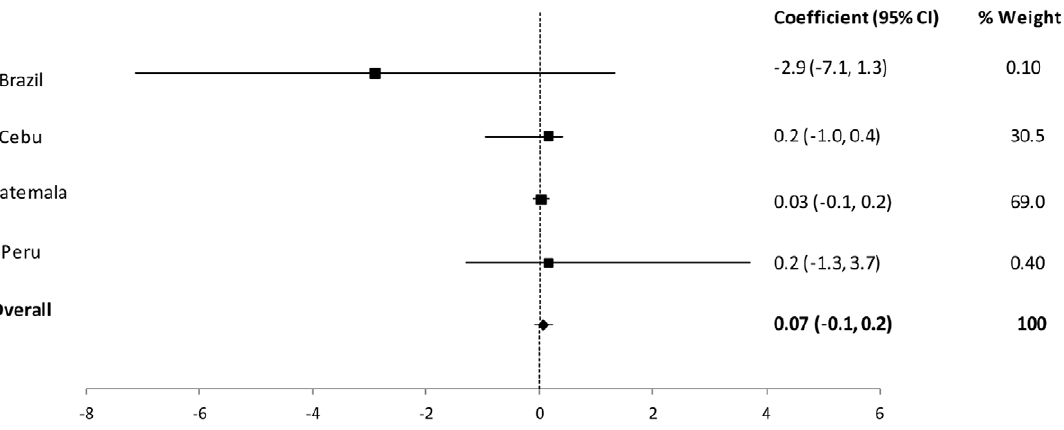
Figure 1. Forest plot of the change in cognitive Z-score per 1% increase in diarrhea prevalence controlling for LAZ score as a continuous variable, mother’s education, sex, age at cognition and SES.